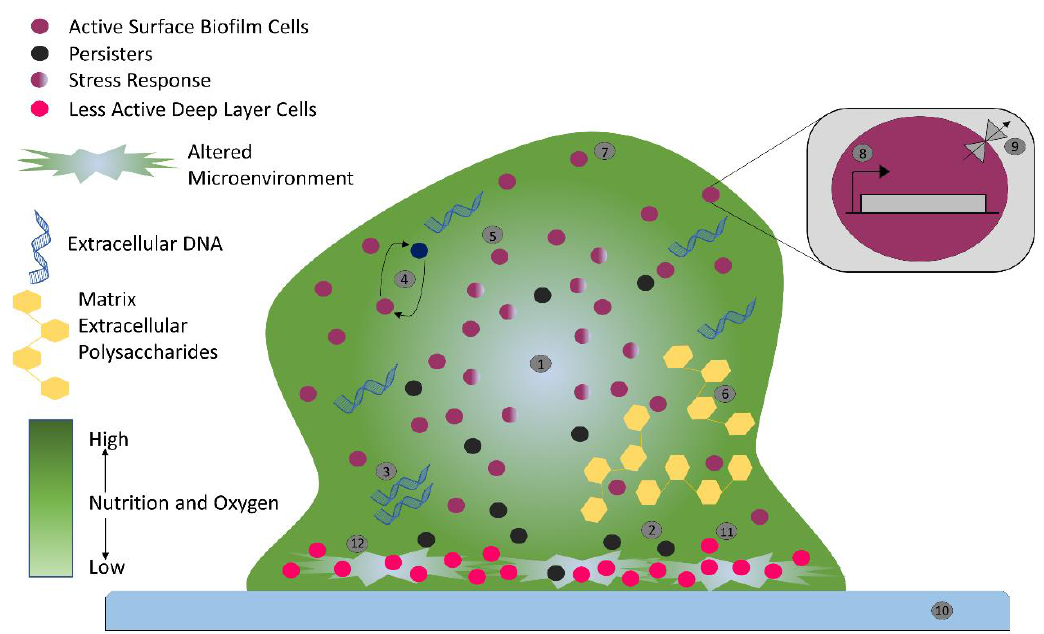
Figure 3. Biofilm-mediated antimicrobial resistance in bacteria: nutrient gradient indicated by color gradient ( 1 ), persister cells ( 2 ), extracellular DNA ( 3 ), intercellular interactions ( 4 ), stress response ( 5 ), matrix extracellular polysaccharides ( 6 ), biofilm cells ( 7 ), genetic determinants ( 8 ), multidrug efflux pump ( 9 ), host surface ( 10 ), less active deep layer cells ( 11 ), and altered environment ( 12 ).